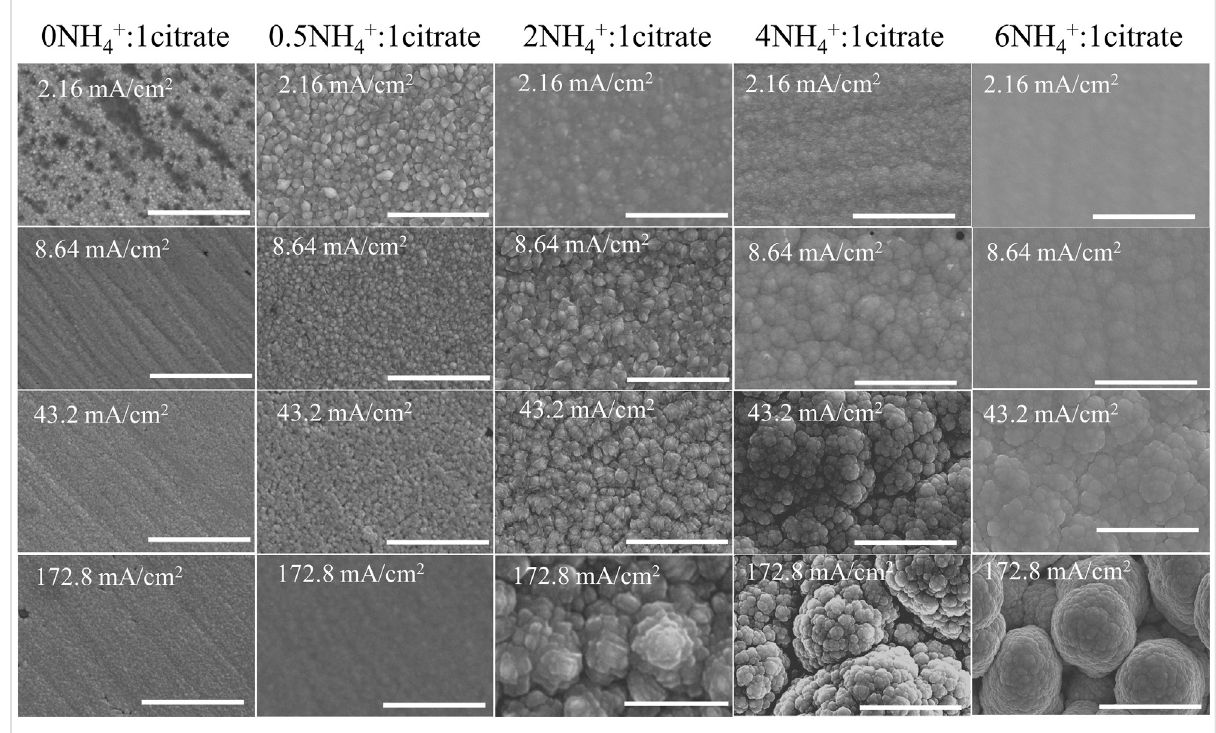
FIGURE 7 SEM images of deposits at different ammonium-to-citrate molar ratio and current density at fi xed 0.1 M Ni 2+ , 0.05 M MoO 4 2- , 0.05 M citrate, and 0.2 M NH 4 + . Scale bar: 3